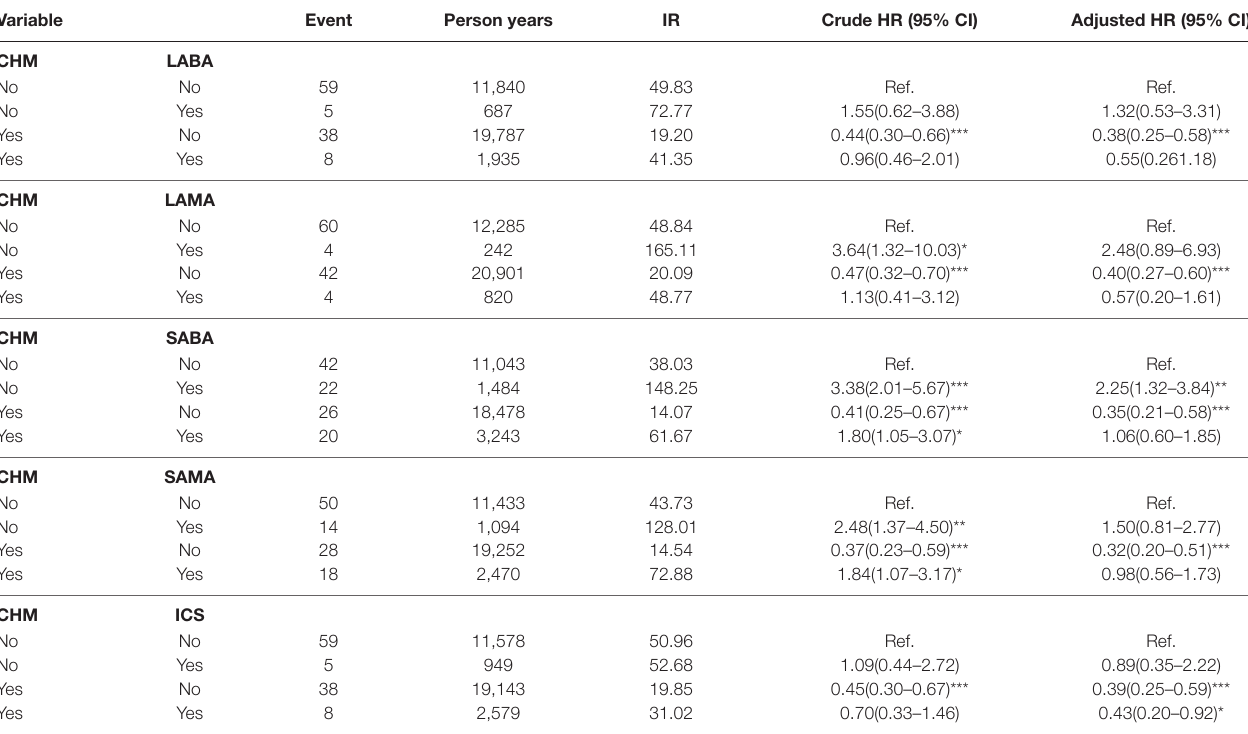
TABLE 6 | Cox proportional hazard regression analysis for the risk of lung cancer associated with COPD